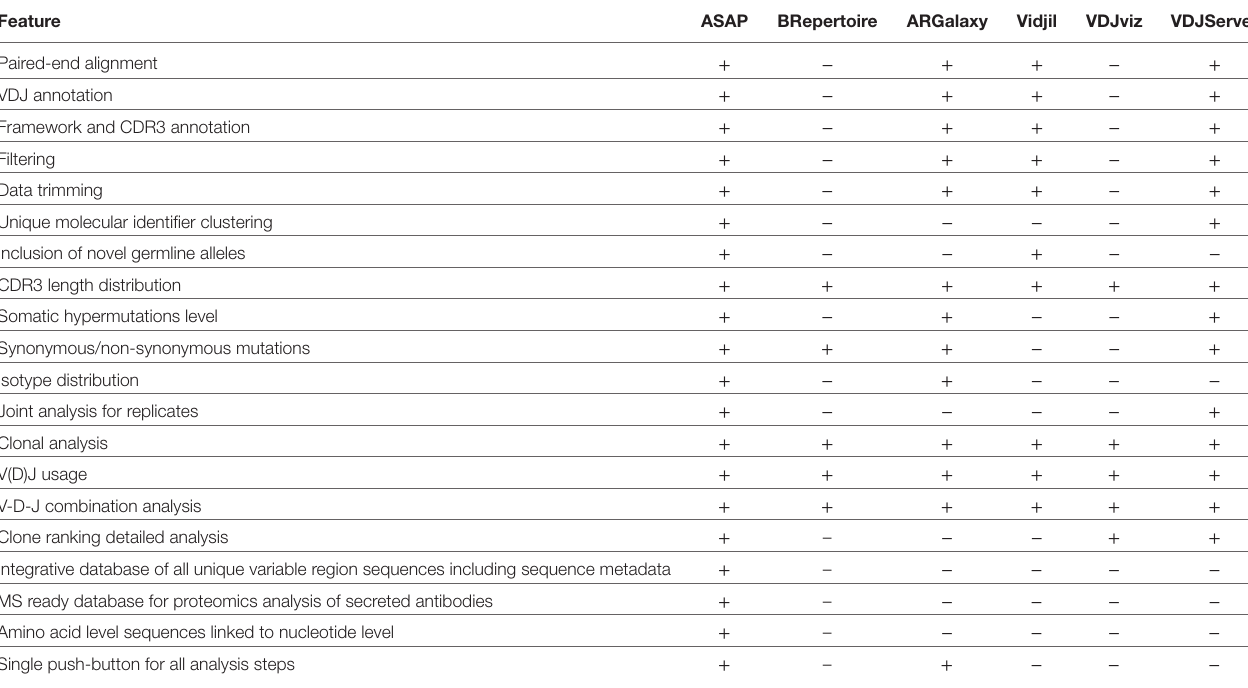
TABle 1 | Summary of the analyses supported in ASAP compared to other related webservers.